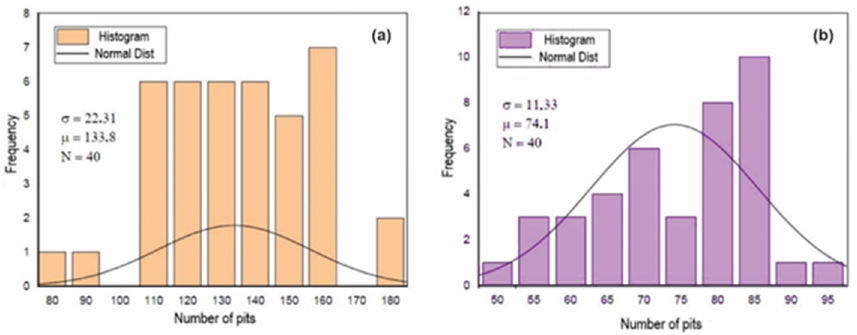
Figure 11. Histogram of the number of pits per analyzed area after the corrosion test for the A2 ( a ) and B2 ( b ) samples.